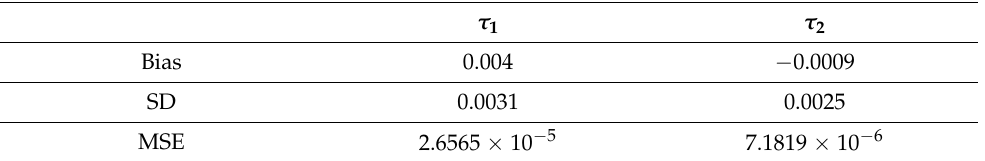
Table 1. Bias, SD and MSE according to the parameter τ for PLGSIMF with the identity link function and n = 500.